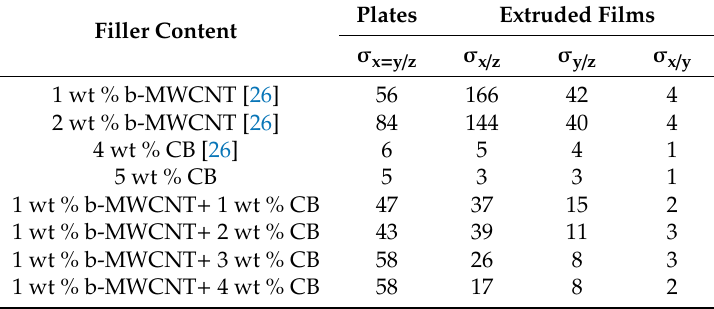
Table 2. Comparison of conductivity ( σ ) quotients measured in two and three directions for compression-molded plates and extruded films (film extrusion temperature of 225 ◦ C, take-o ff velocity at 2.5 m /